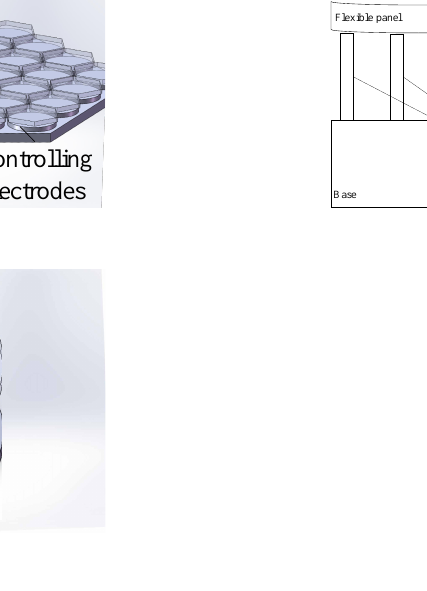
Figure 2. ( a ) Schematic section of the micromachined membrane deformable mirror. ( b ) Schematic section of the piezoelectric deformable mirror. ( c ) Schematic section of the fast steering